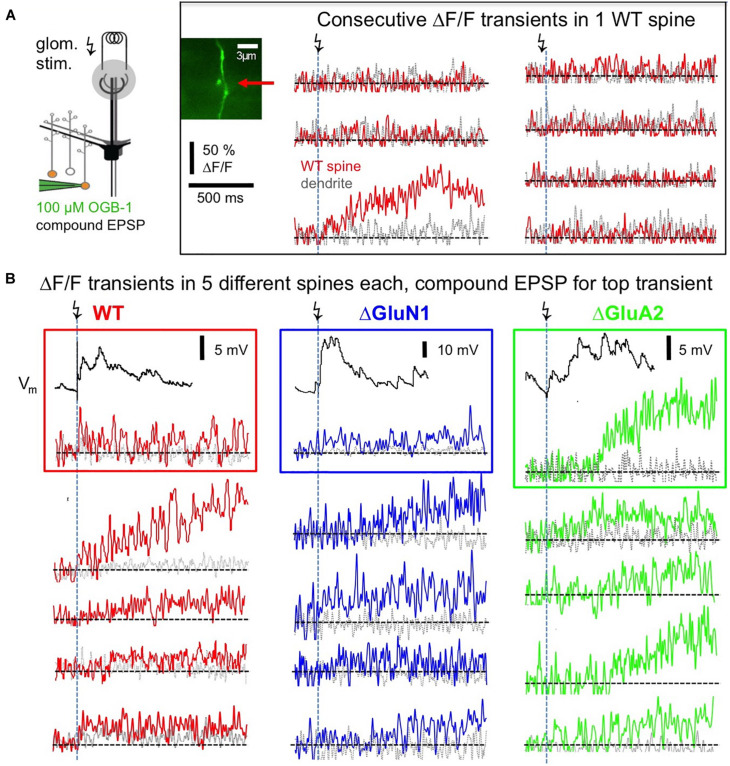
Postsynaptic responses in adult WT, ΔGluA2 and ΔGluN1 GC spines. (A) Left: Scheme of experiment (modified from Abraham et al., 2010, their Figure 2). Electrical glomerular stimulation and whole-cell recording of the resulting compound EPSP from a GC, including two-photon imaging of a responding spine and its adjacent dendritic shaft. Genetically modified GCs (ΔGluA2 and ΔGluN1) were identified by the expression of the fluorescent construct Kusabira-Orange. Middle: scan of a WT spine and dendrite. Right: line scans through the spine and dendrite during consecutive glomerular stimulations. Only one response occurred (3rd trace), that shows a slowly evolving Ca2 + transient confined to the spine head. (B) Single responses from other spines, with each trace imaged in a different spine. Same scales for ΔF/F and time as in (A). Top transients with their associated compound EPSP recordings. Left (red): WT GCs. Middle (blue): ΔGluN1 GCs. Right (green): ΔGluA2 GCs. Note the larger size and yet slower evolution compared to WT and ΔGluN1.